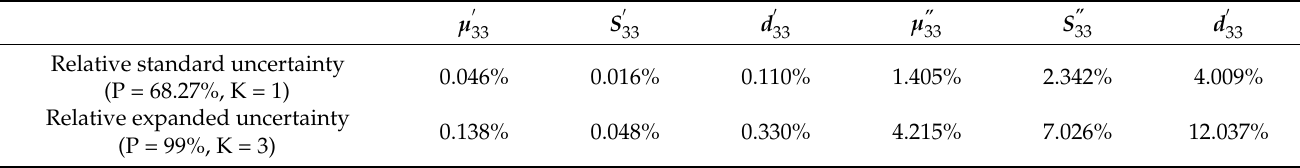
Table 8. Relative uncertainties of material complex parameters extracted by Method